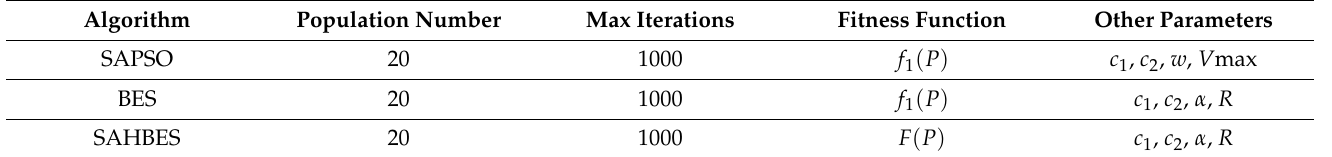
Table 2. Algorithms’